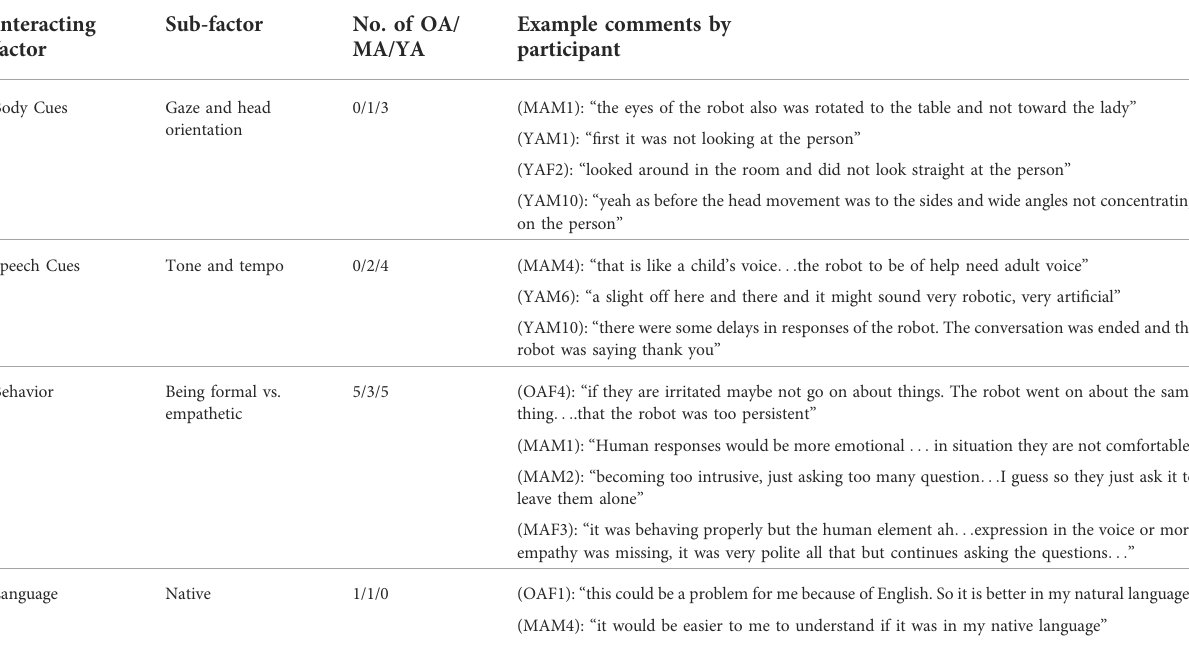
TABLE 4 Interacting: the fi rst and second columns list the factors and sub-factors, which were perceived contributing to breakdown situations relatingtothethemeinteracting.Thethirdcolumnshowsthenumberofolderadults(OA),middle-agedadults(MA),andyoungeradults(YA)who commented on each factor, and the fourth column provides examples of